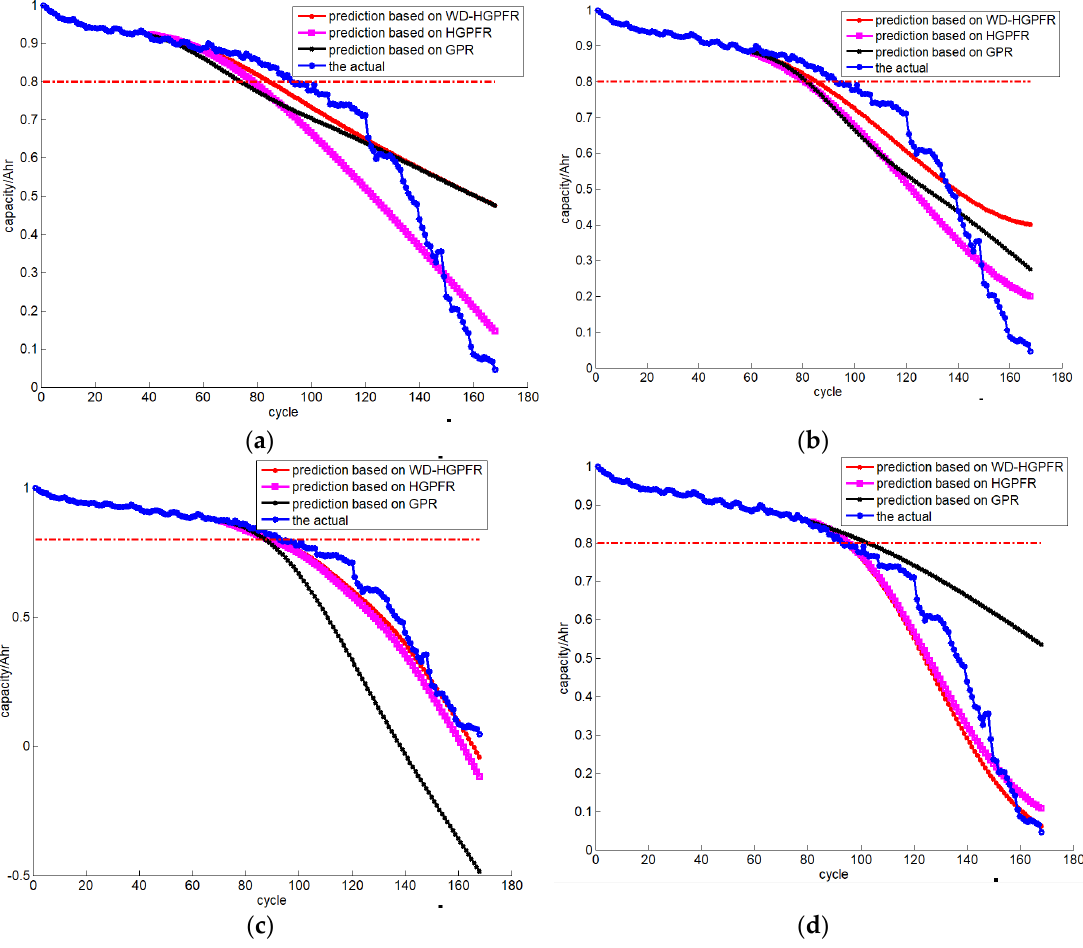
Figure 10. Prediction results using different models with different lengths of training data for Cell-33 battery. ( a ) RUL prediction results with 40 training data, ( b ) RUL prediction results with 60 training data, ( c ) RUL prediction results with 70 training data, and ( d ) RUL prediction results with 80 training data.